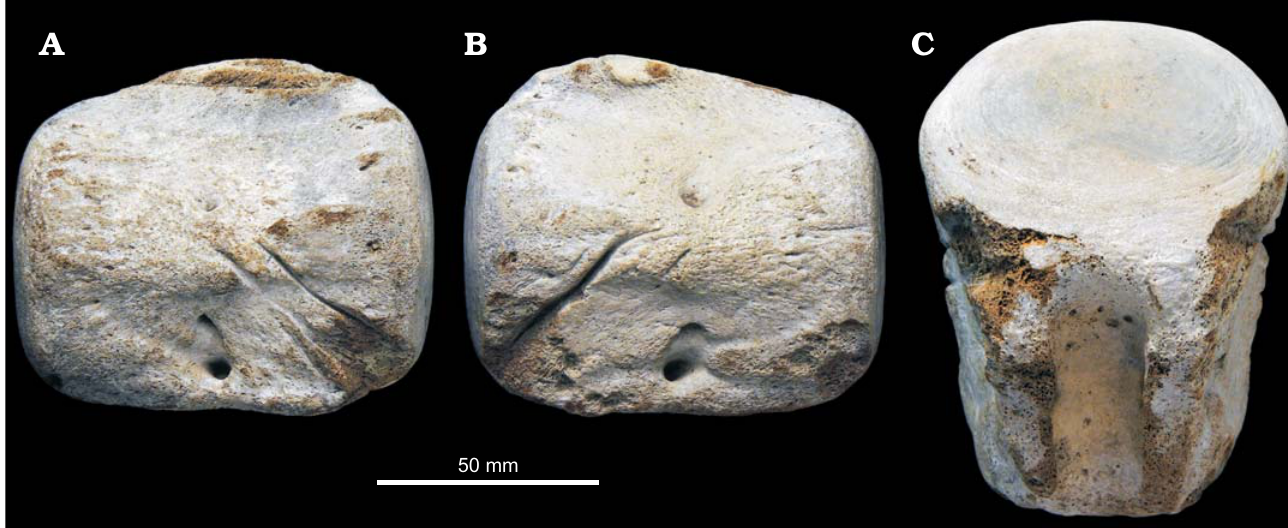
Fig. 1. A Neogene odontocete caudal vertebra, CMM-V-4360 from a spoil pile within the PCS phosphate mine in Aurora, North Carolina, USA. Peduncu- lar vertebra in right ( A ) and left ( B ) lateral views and anteroventral ( C ) view. The deep diagonal gouges on the anteroventral margin of the vertebra were created when the vertebra was repeatedly wedged between two adjacent